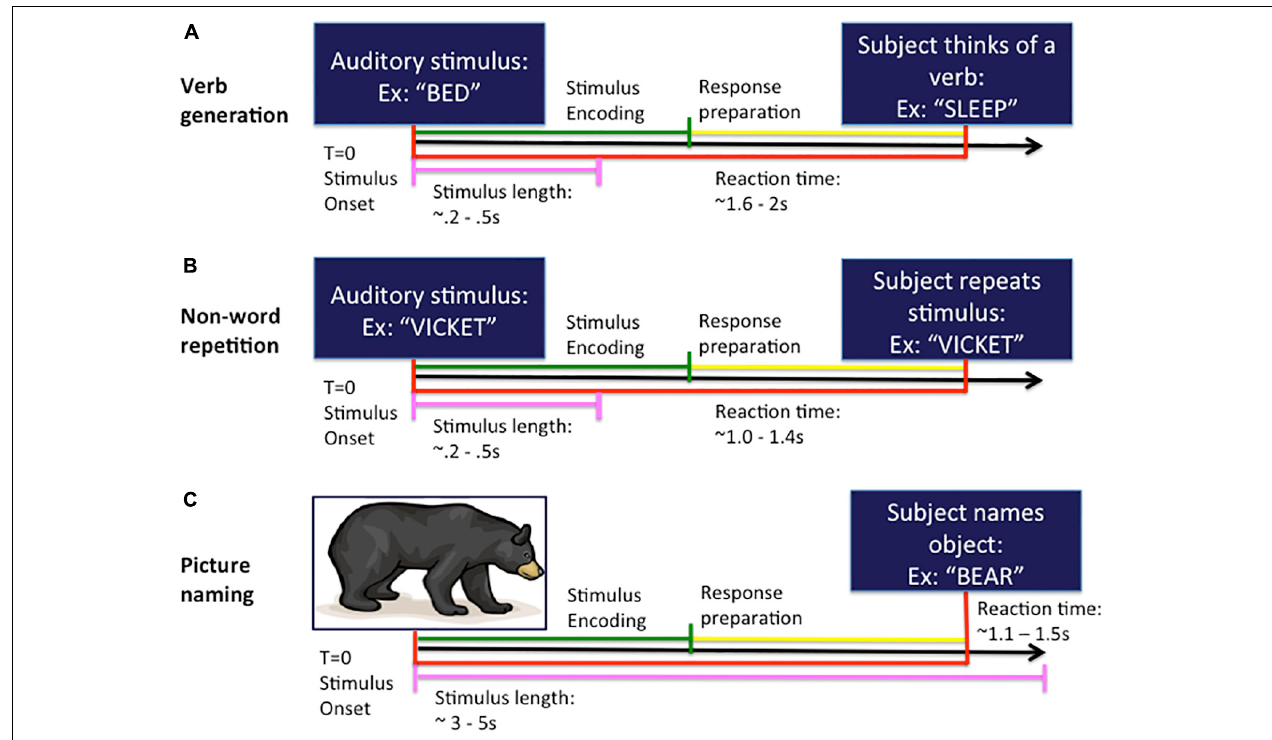
FIGURE 1 | Task design for the verb generation (A) , non-word repetition (B), and picture naming (C) tasks. In each task, the subject is presented with either an auditory (A,B) or visual (C) stimulus at the beginning of the trial (time T = 0 ms) and responds by speaking into the microphone at response onset. Trials are organized into stimulus encoding (in green) and response preparation (in yellow) windowed segments prior to